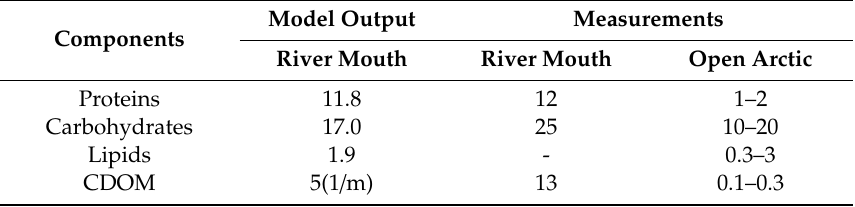
Table 3. River mouth values from the model with a summary of measurements at Arctic entryways, and for the surface of the open Arctic Ocean. Marine data are included since we will argue that high discharge plumes raise organic functional group levels above those required for regional biophysical e ff ects. Units are the usual micromolar of carbon excluding CDOM absorption, which is proportional and detailed in the